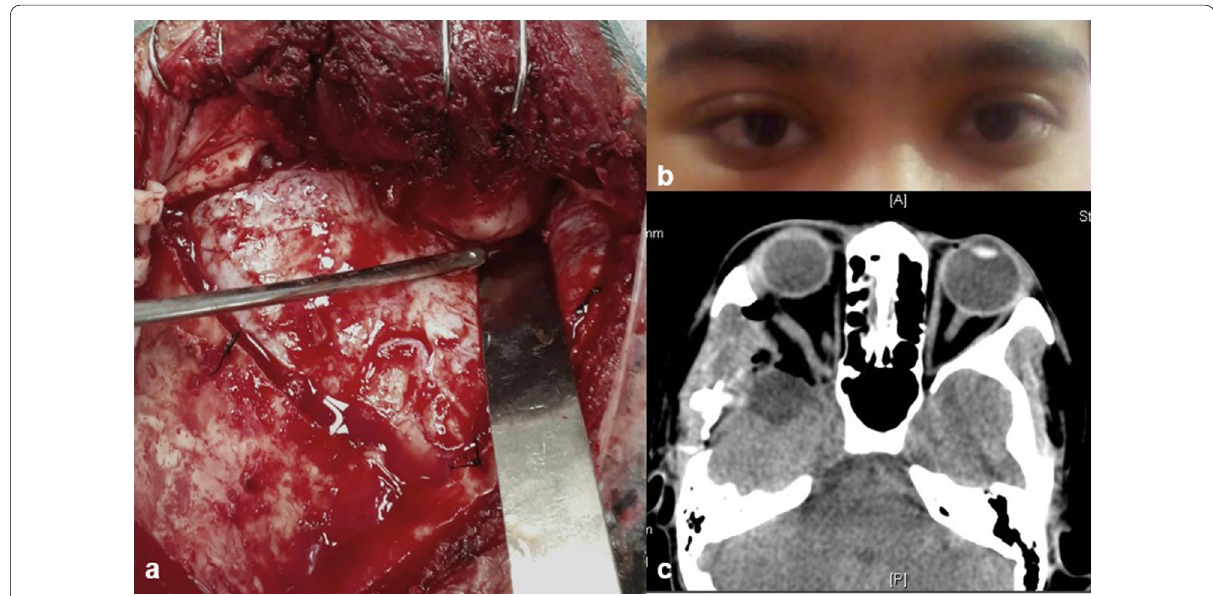
Fig. 2 a Intraoperative image showing an expansile lesion originating from the greater wing of sphenoid. b Clinical image showing resolution